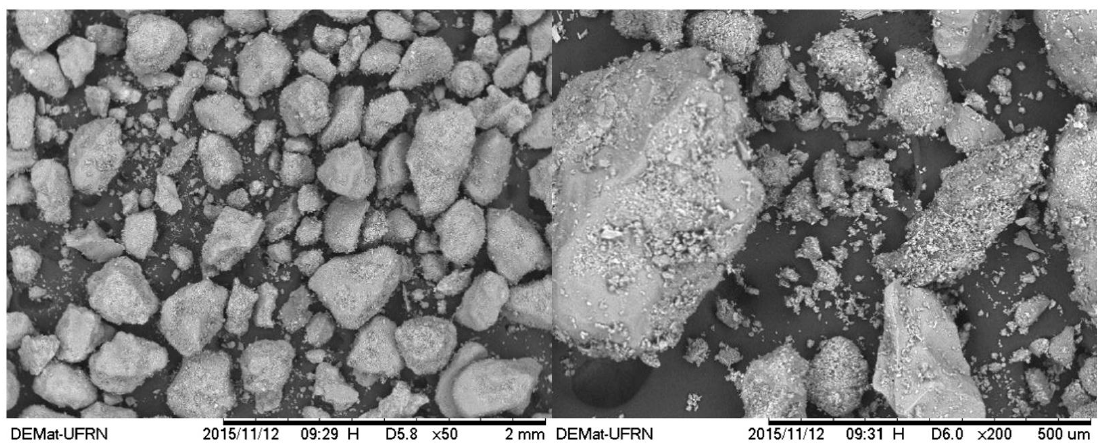
Figure 4. SEM image of obtained recycled aggregate